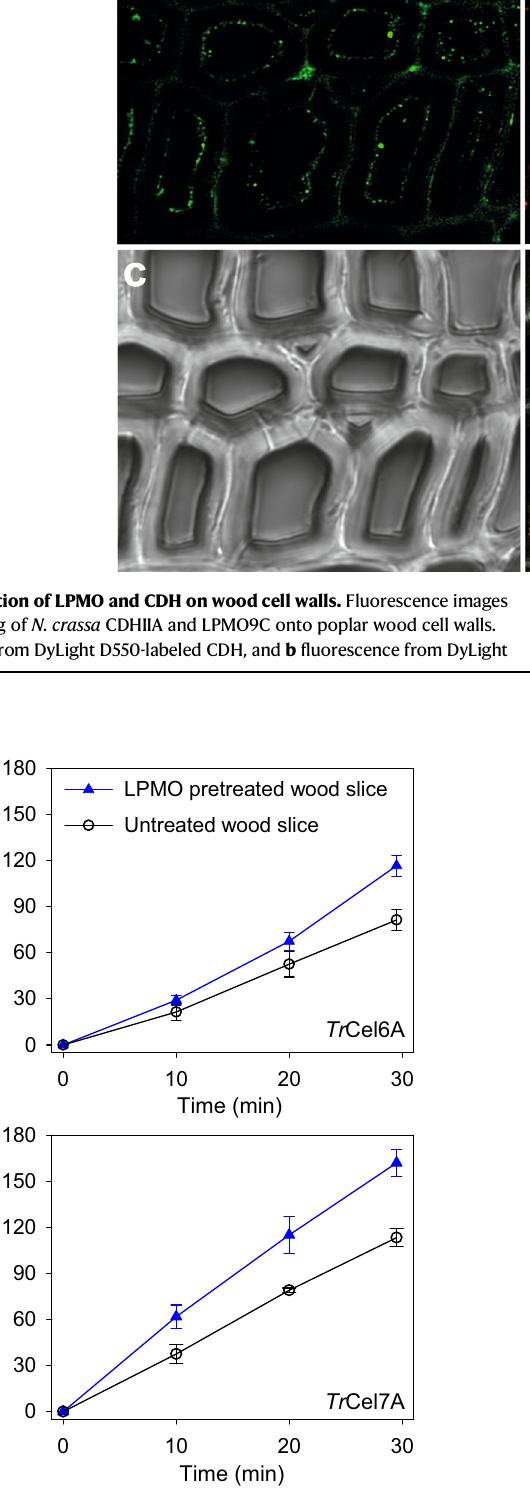
Fig. 7 | Effect of H 2 O 2 -driven LPMOs catalysis on cellobiohydrolases activity. Glucose production by Tr Cel6A ( a ) and Tr Cel7A ( b ) while degrading the untreated (black circles) and pretreated (blue triangles) poplar wood slices by Nc LPMO9C withitsreductantand H 2 O 2 ascosubstrate.Allreactionsare conductedina50mM potassium phosphate buffer, pH 6.0 at 20°C. Data are shown as mean values and error bars show SD ( n =3, independent